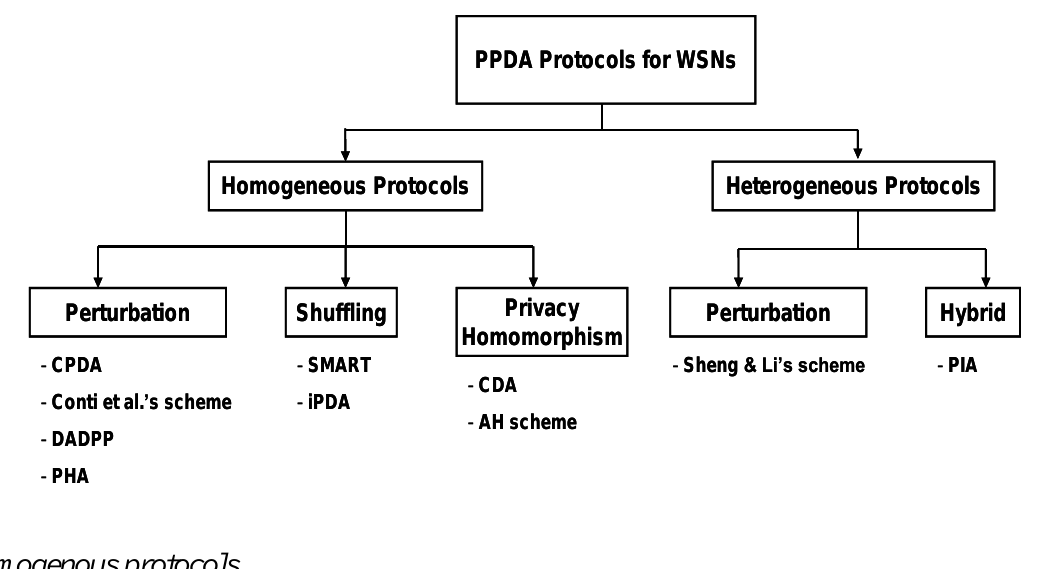
Figure 1. Classification of the existing PPDA protocols for